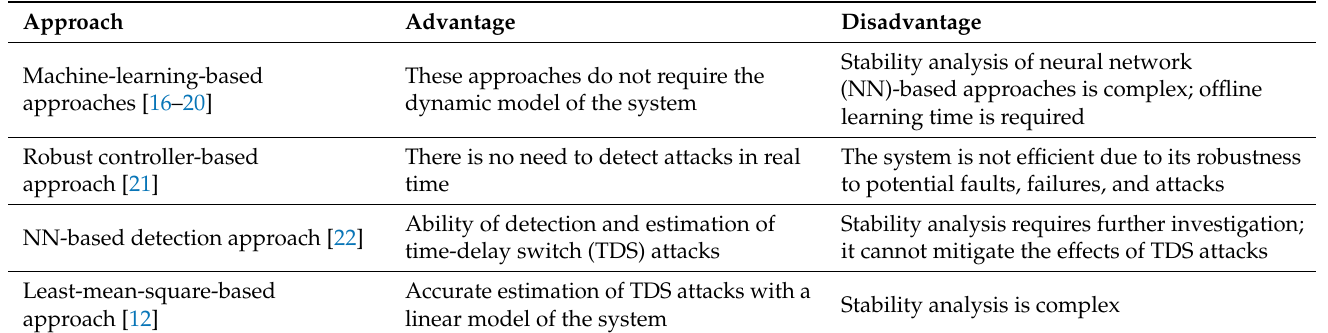
Table 1. The advantages and disadvantages of the approaches in the